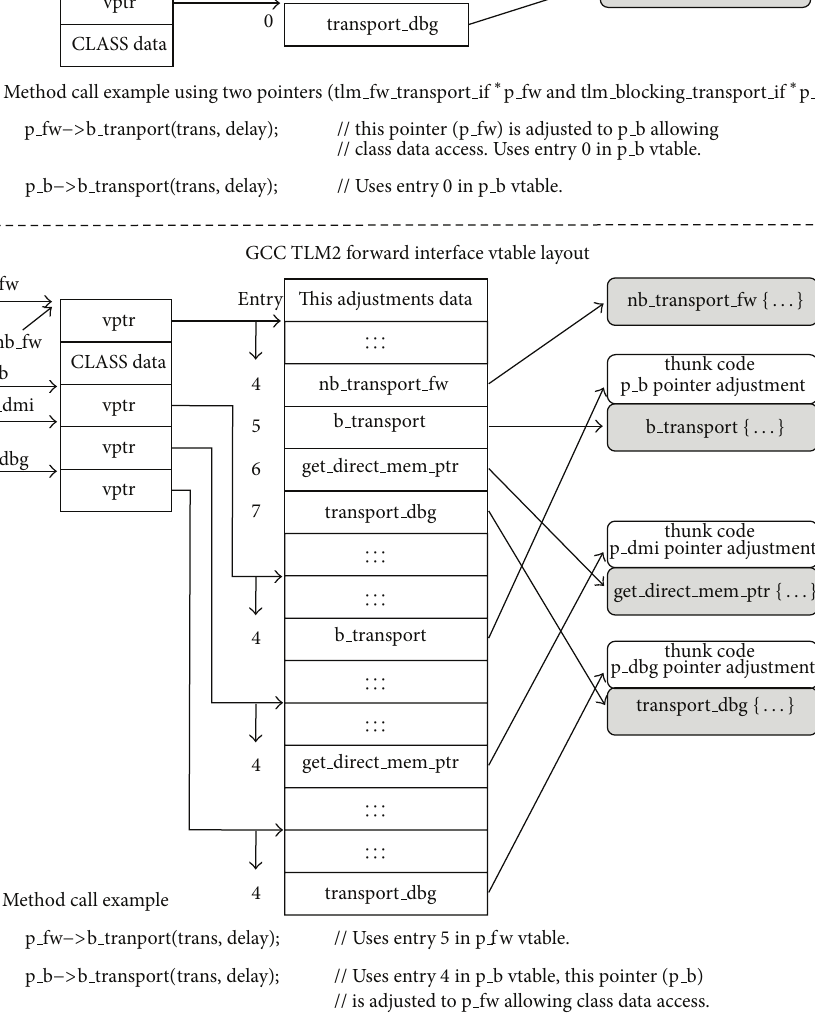
Figure 5: Microsoft VC versus GCC TLM2 forward interface binary